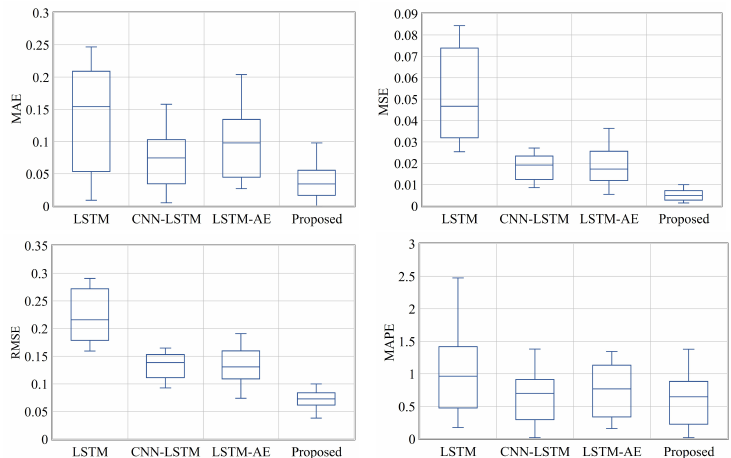
Figure 10. Prediction results of different methods on the IHEPC dataset at a 15-min